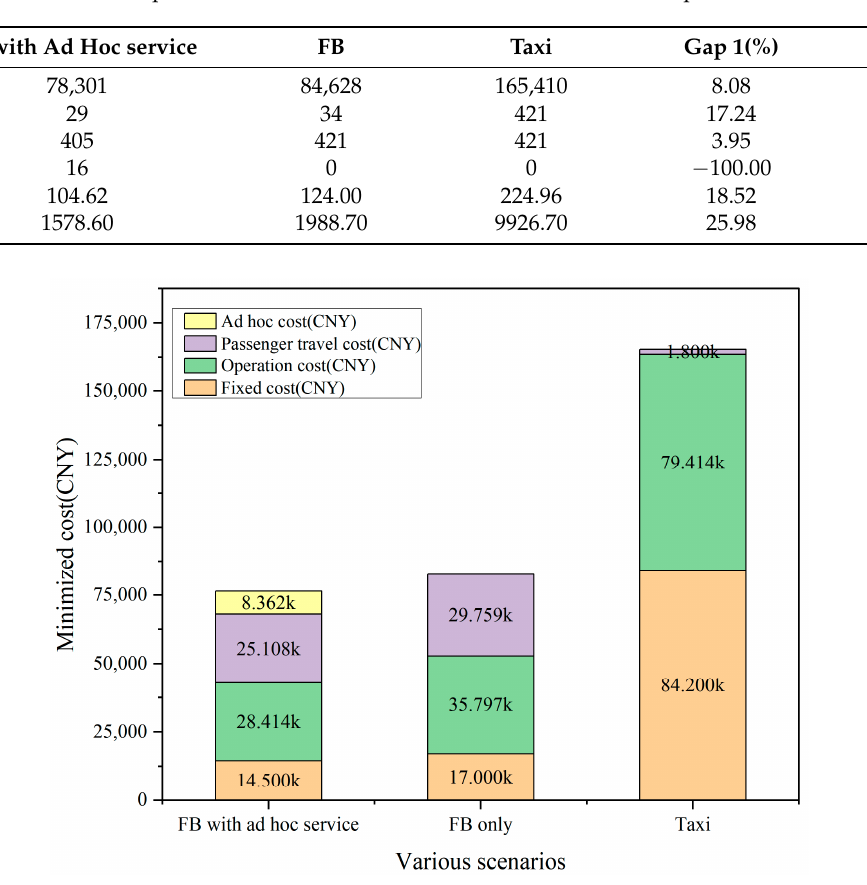
Figure 13. Different costs of various scenarios in Shenzhen airport.